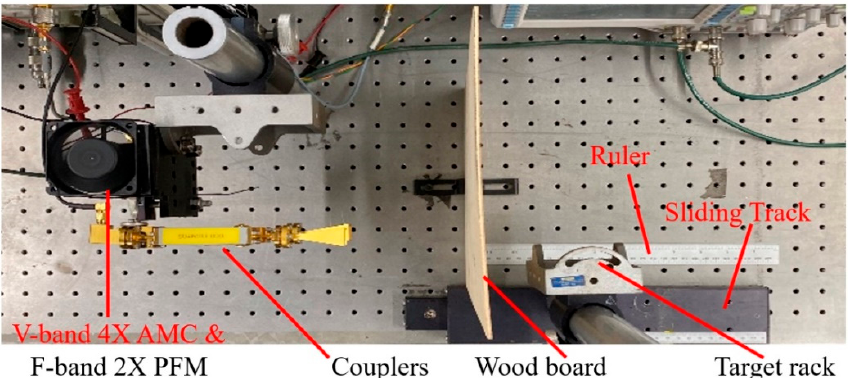
Figure 5. Photographs of the prototype F-band swept-FM radar system and the translatable target region.